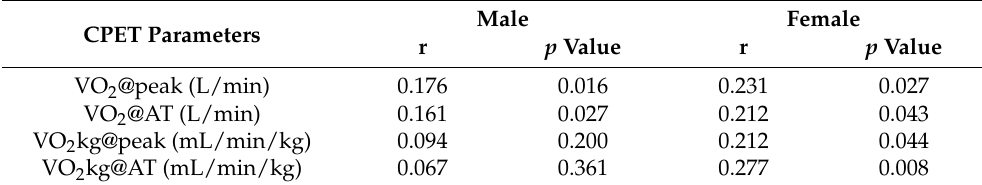
Table 2. The correlation between oxygen uptake volume and